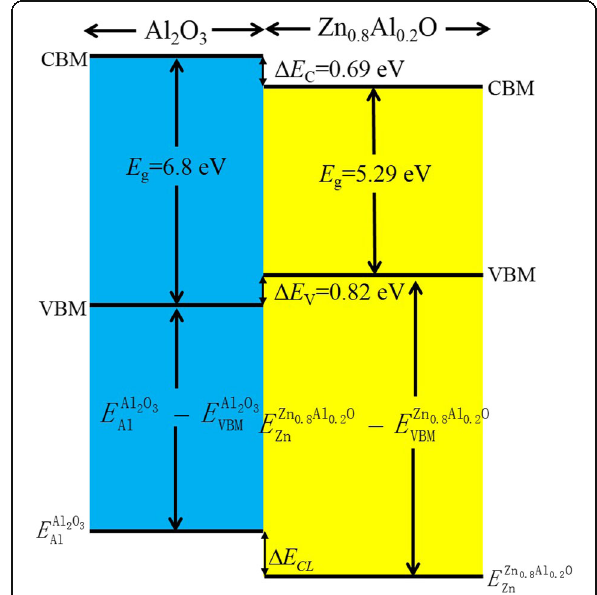
Fig. 7 The schematic diagram of band offset at the Al 2 O 3 /Zn 0.8 Al 0.2 O heterojunction